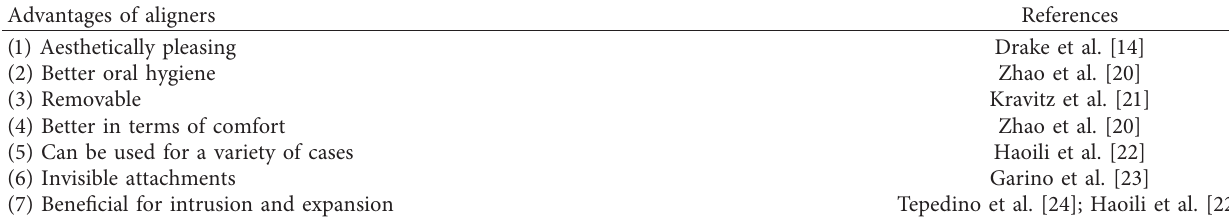
Table 1: List of advantages of using clear